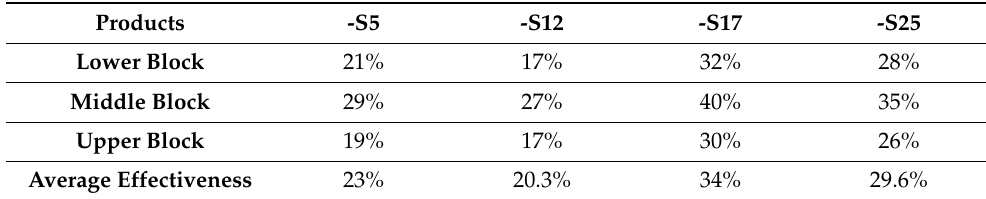
Table 2. Total temperature non-uniformity reduction of blocks with different spacer sizes in Config-2 compared to Config-2-S0.